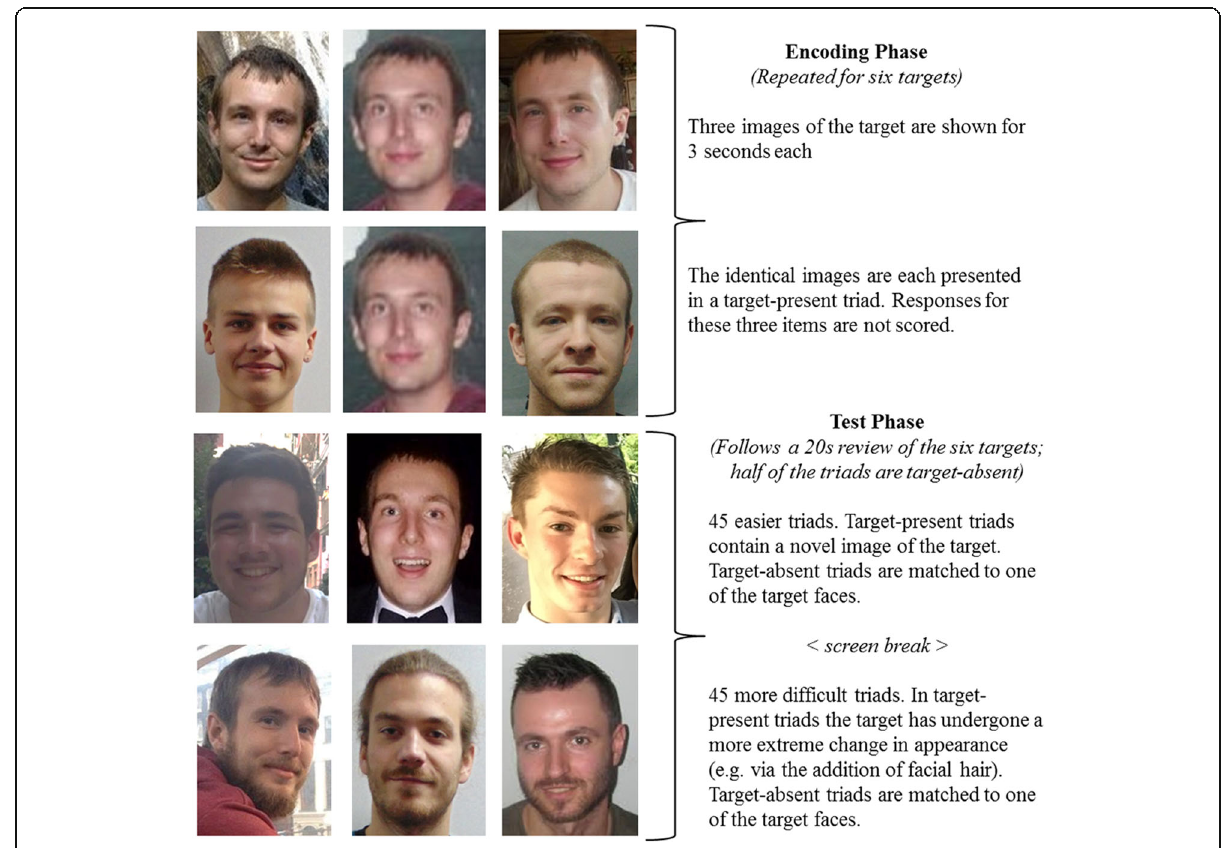
Fig. 1 Sample stimuli from the MMT. Note that these trials are all target-present. Due to issues with image permissions, this figure only displays images that resemble those used in the actual